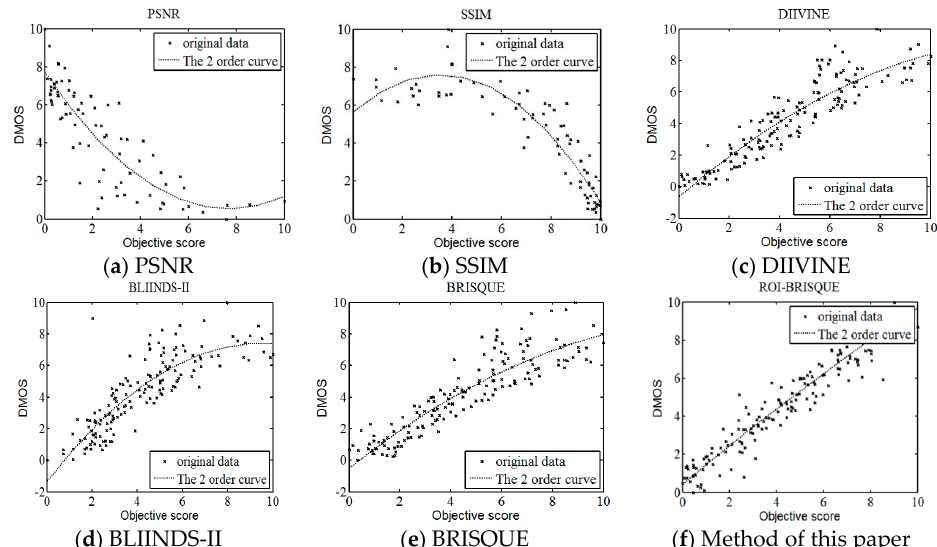
Figure 13. Scatter plots of DMOS versus different model predictions. Each sample point represents one test image in the entire LIVE database. (a) PSNR model; (b) SSIM model; (c) DIIVINE model; (d) BLIINDS-II model; (e) BRISQUE model; (f) Model of this paper (ROI-BRISQUE).